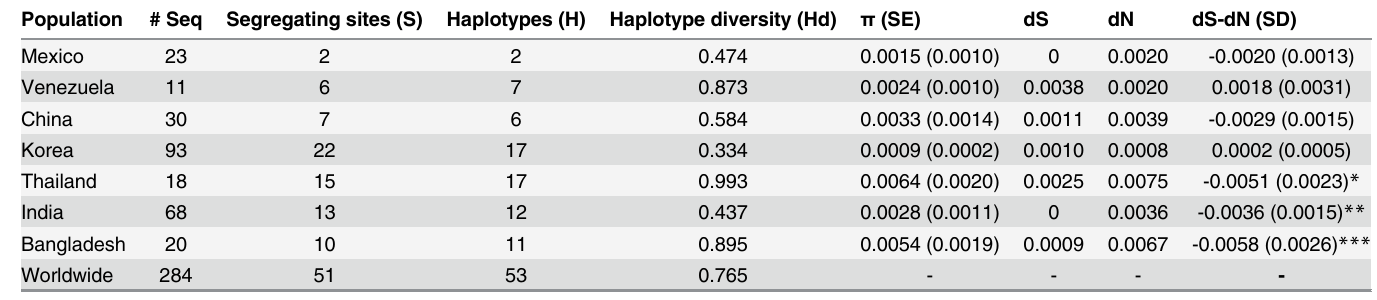
Table 3. Pvs28 gene worldwide polymorphism by